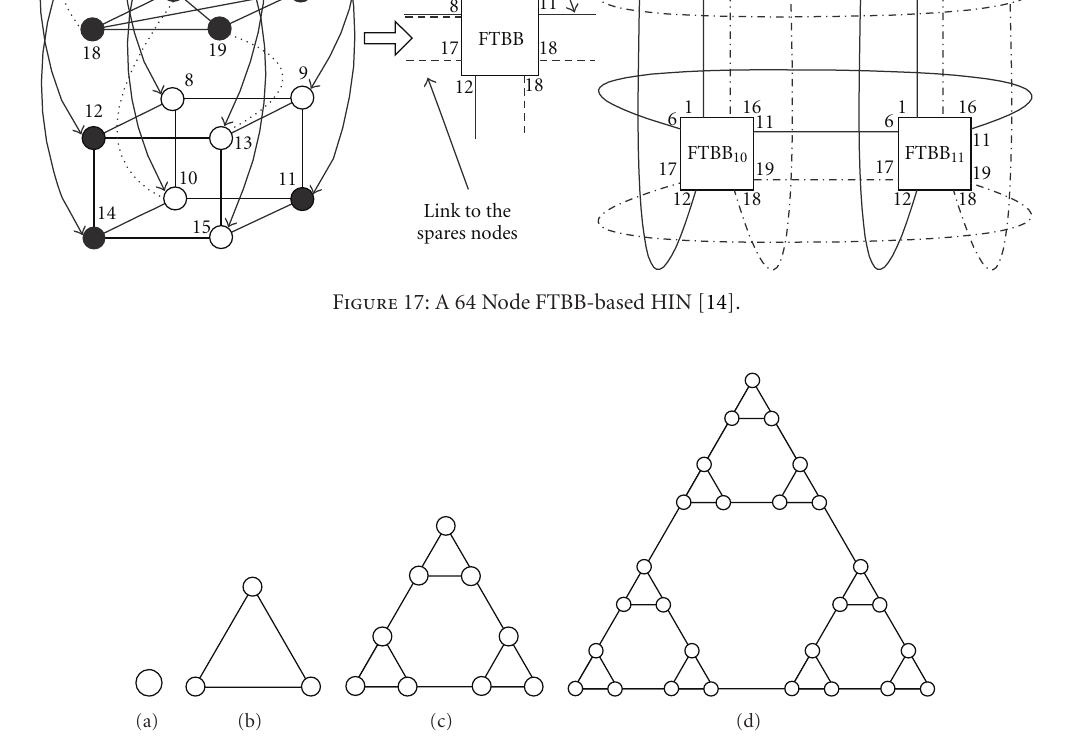
Figure 18: (a) Level 0 THIN, (b) level 1 THIN, level 2 THIN, and level 3 THIN [15].